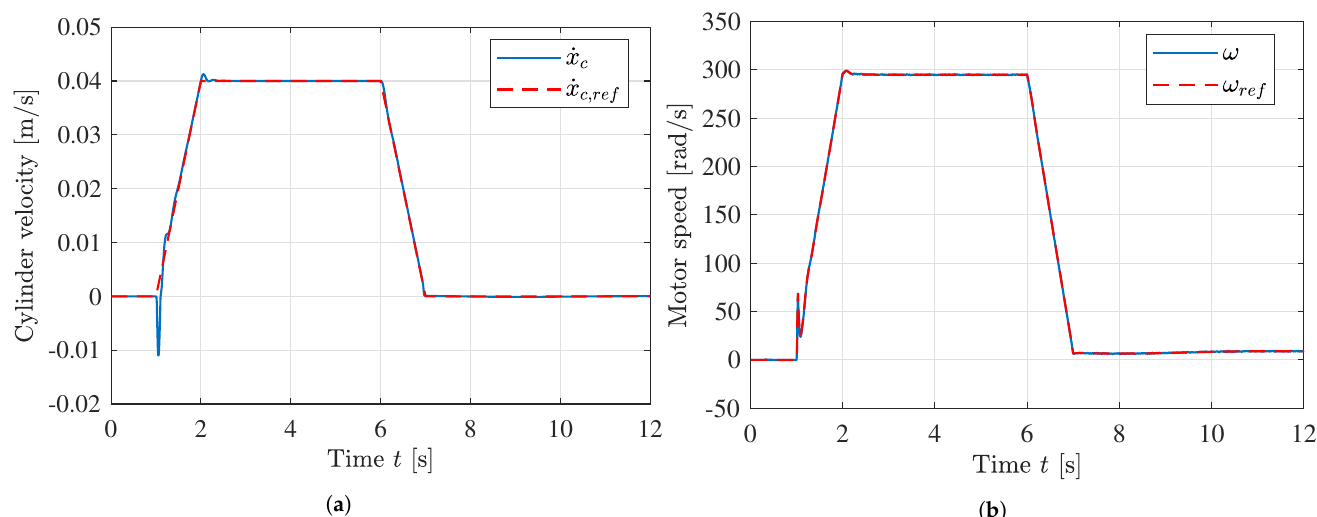
Figure 17. Cylinder velocity and motor speed for operation in quadrant 1. ( a ) Cylinder velocity ˙ x c ; ( b ) Motor speed ω .